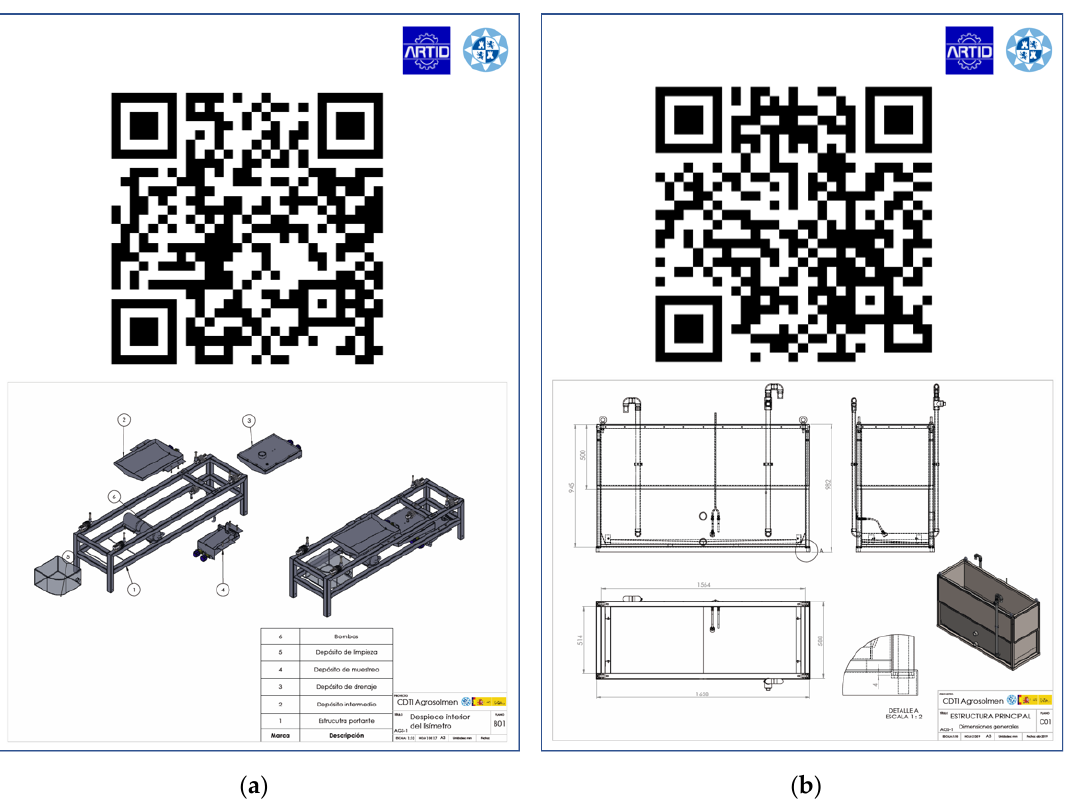
Figure 11. Example of the ferticontrol equipment drawings with QR codes: ( a ) inner structure; ( b ) main structure.